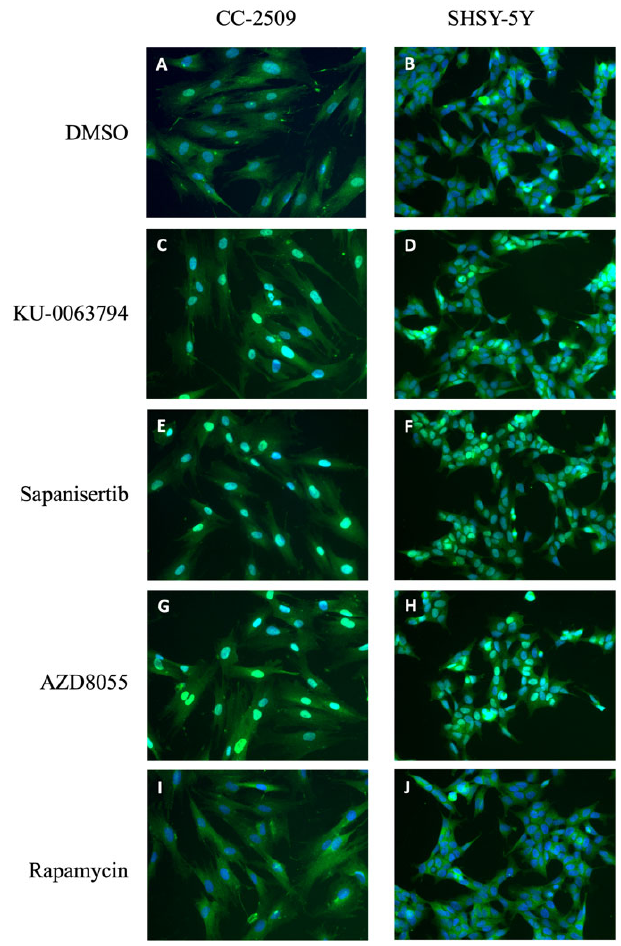
Figure 4. Effect of mTORC inhibitors on nuclear translocation of FOXO3 in fibroblast and neuroblastoma cell lines. mTORC1 inhibition does not affect FOXO3 localization. Immunocytochemistry for FOXO3a was carried out in fibroblasts (CC ‐ 2509) and a neuroblastoma (SH ‐ SY5Y) cell line treated for 1h with ( A , B ) 0.5% DMSO or 1 μ M ( C , D ) KU ‐ 0063794, ( E , F ) sapanisertib, ( G , H ) AZD8055 or ( I , J ) rapamycin. After compound treatment, cells were fixed and incubated with a green fluorescent specific antibody against FOXO3 and DAPI for nuclear staining and imaged with fluorescence microscopy. Representative images taken at 20× magnification are shown.